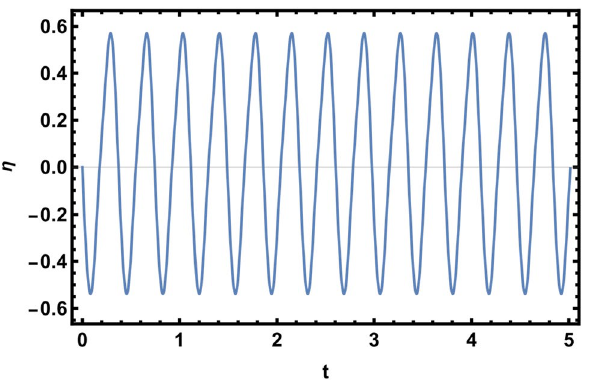
Figure 14. Disturbed response as specified in Eq.